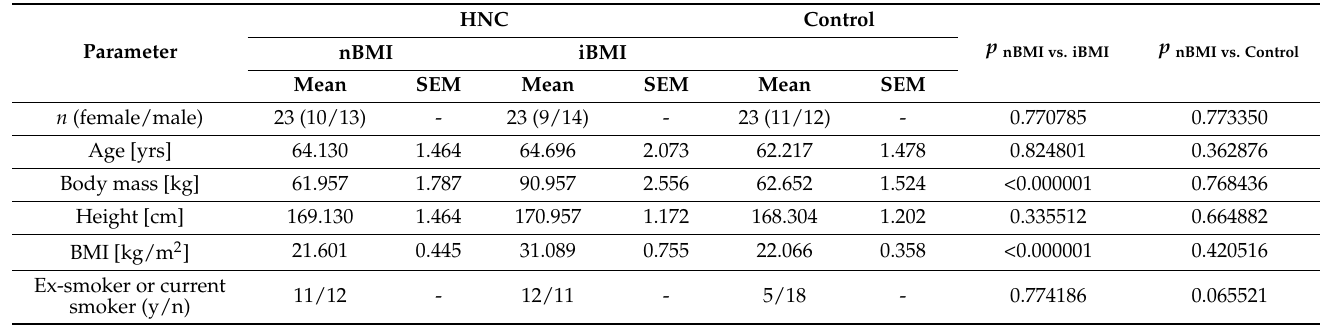
Table 1. Anthropometric and clinical characteristics of patients with head and neck cancer (HNC groups) and healthy volunteers (control group). Each value represents the mean ± S.E.M.